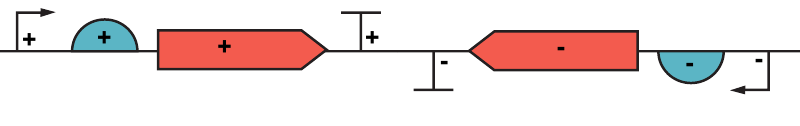
Figure 11: Example construct incorporating both inline (+) and reverse complement (-) features.